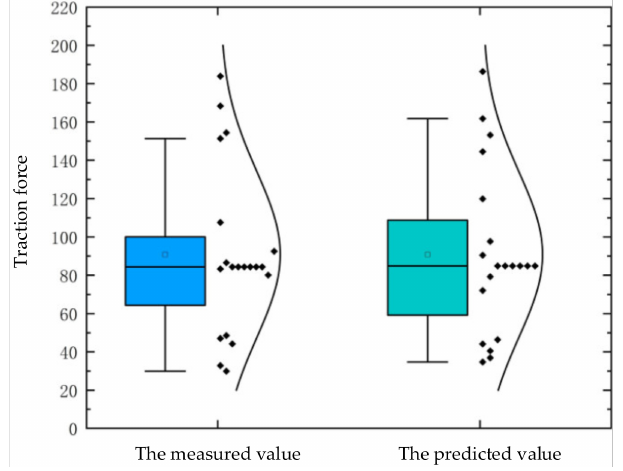
Figure 13. Normal comparison chart of the measured values and the predicted values of traction.